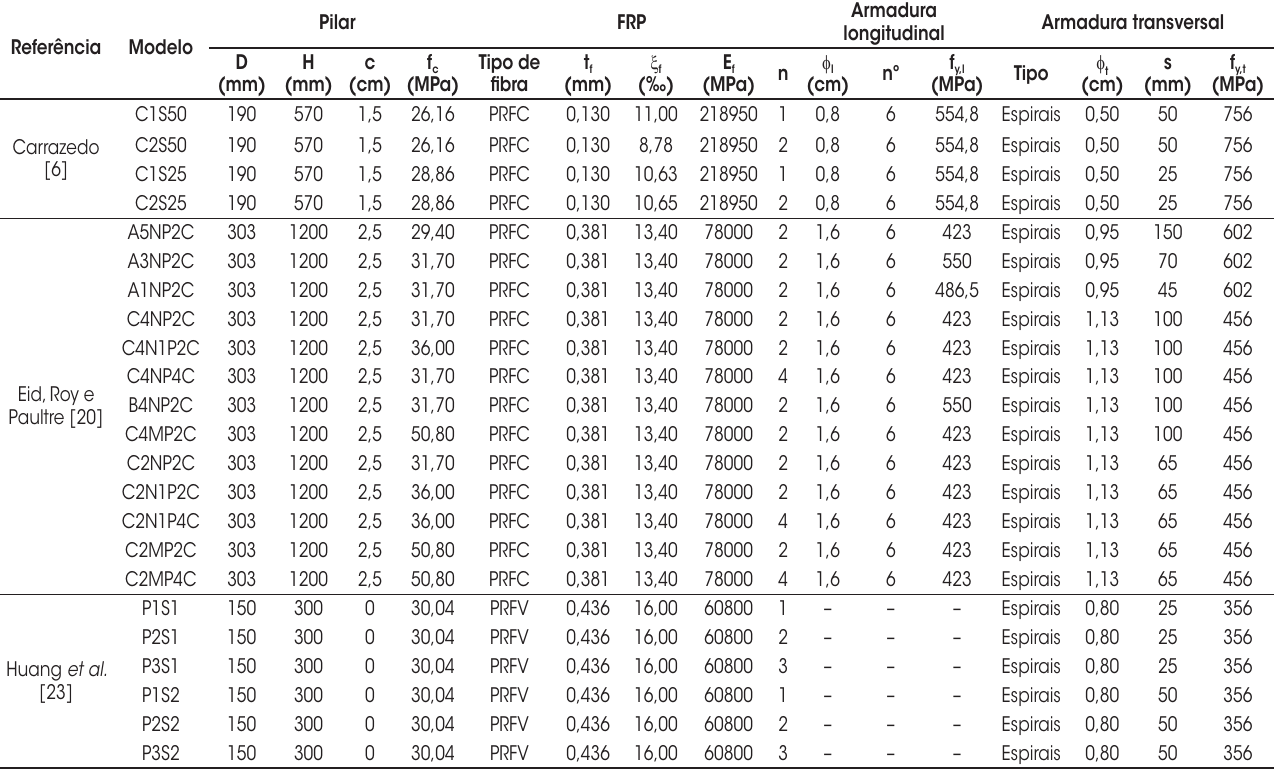
Pilares confinados com PRF e armadura transversal (part